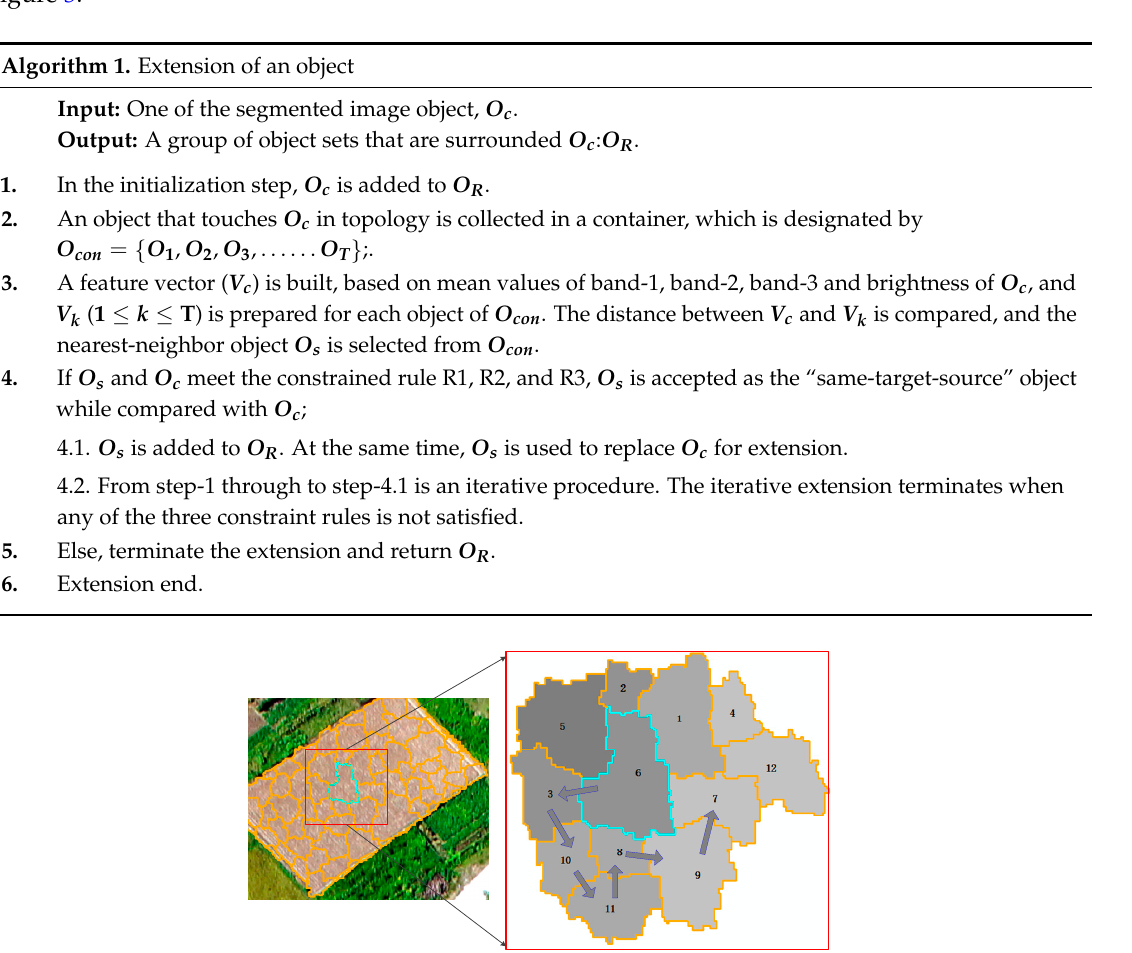
Figure 3. An extension example based on rule constraint. Highlighted object-6 is the central